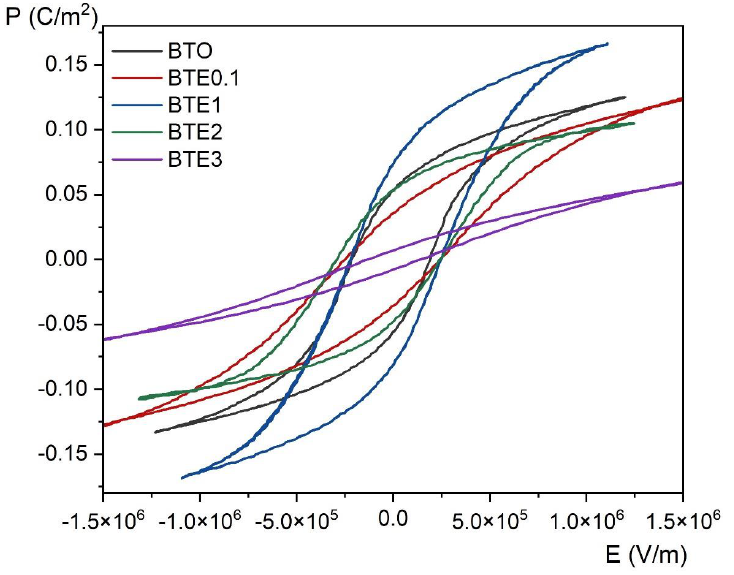
Figure 9. Room temperature P ( E ) hysteresis loops for pure BTO and BTEx (BTE0.1, BTE1, BTE2, BTE3) ceramics.